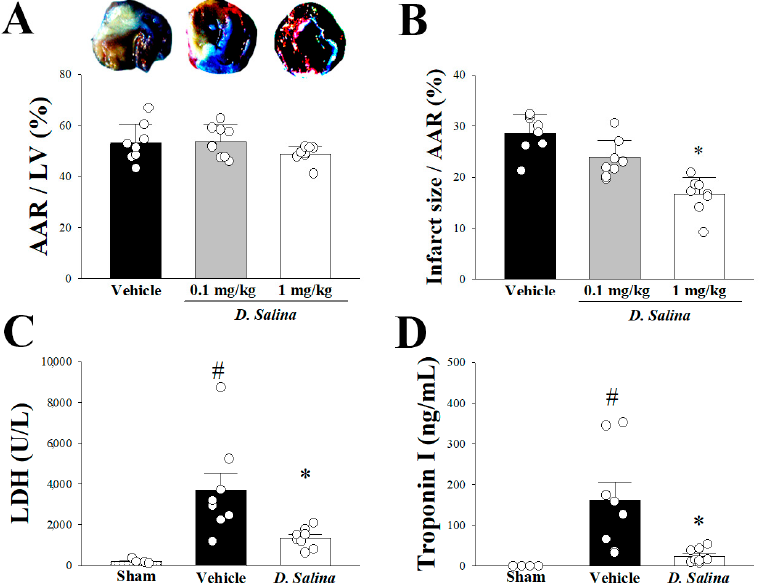
Figure 1. Effect of D. salina on I/R induced myocardial damage in rats. ( A ) Representative Evans blue/TTC staining of heart sections from vehicle-treated group and different dose (0.1 and 1 mg/kg) of D. salina groups after 1 h of LAD coronary artery occlusion and 3 h of reperfusion. Perfused area is seen in blue; area at risk (AAR) is seen in red and white. Infarction is seen in white. Quantitative AAR/Ventricle % (ratio of non-blue area to total area), ( B ) the risk zone infarcted % (ratio of white area to AAR), ( C ) plasma lactate dehydrogenase activity and ( D ) plasma troponin-I level, in vehicle and 1 mg/kg D. salina -treated rats. The results are shown as mean ± S.E.M. ( n = 4–9); # p < 0.05 compared with the sham group; * p < 0.05 compared with the vehicle-treated group.